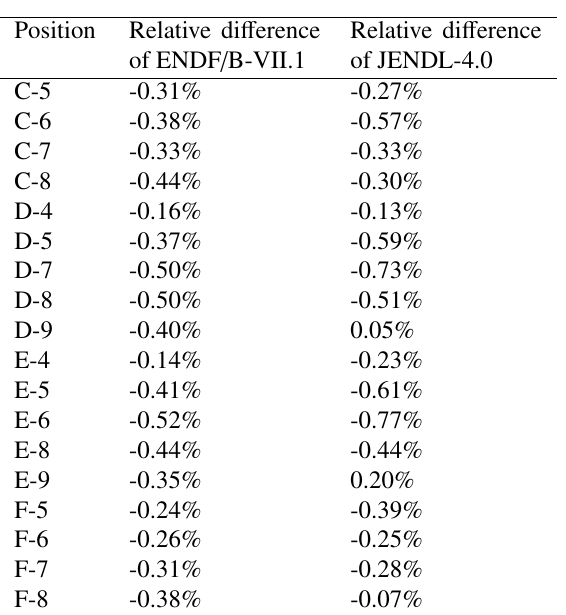
Table 6. Relative fission rate